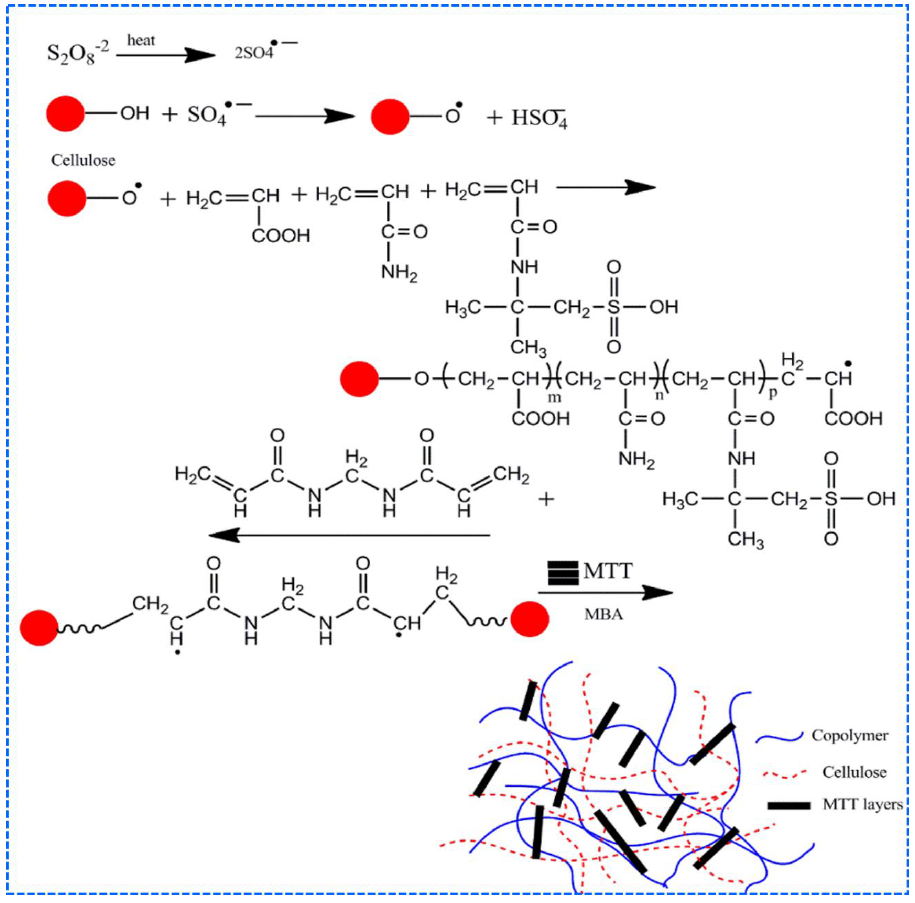
Figure 8. The plausible mechanism of carboxymethyl cellulose-g-poly (acrylamide-co-acrylic acid-co- 2-acrylamido-2-methyl-1-propanesulfonic acid (AMPS)/montmorillonite (MMT)) hydrogel